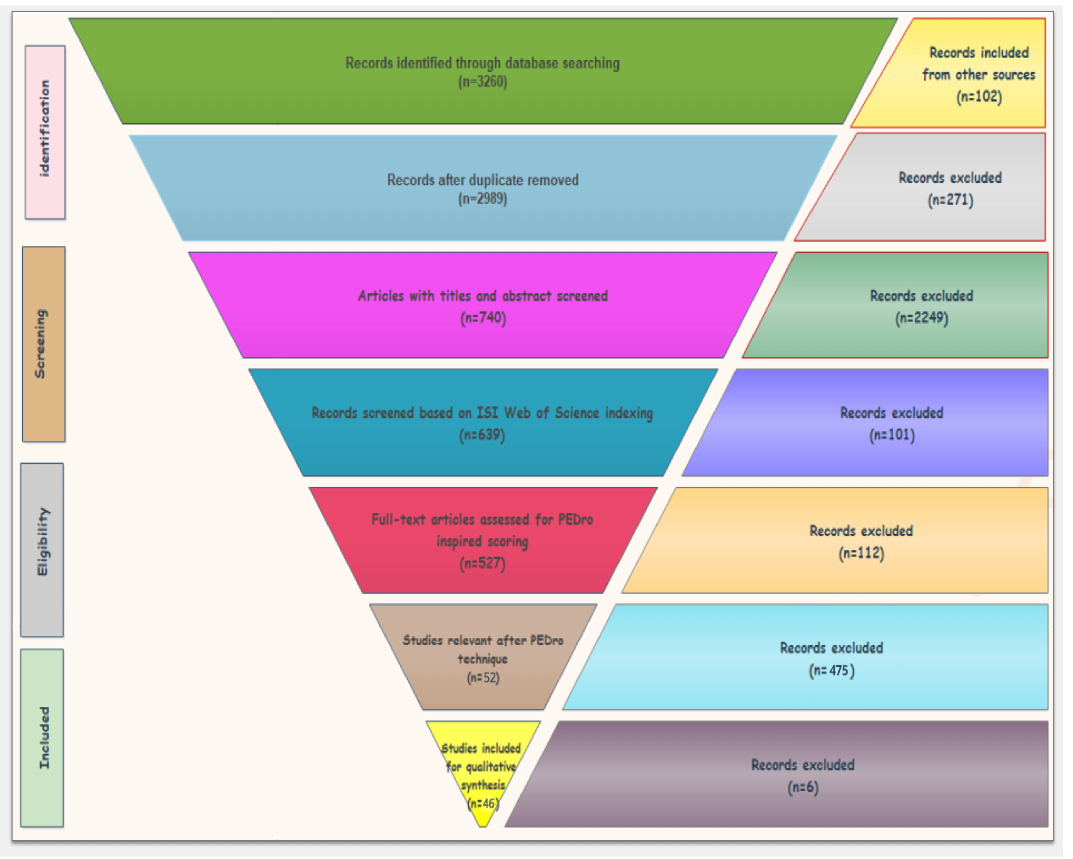
Figure 1. PRISMA adapted flow diagram used for the articles’ systematic